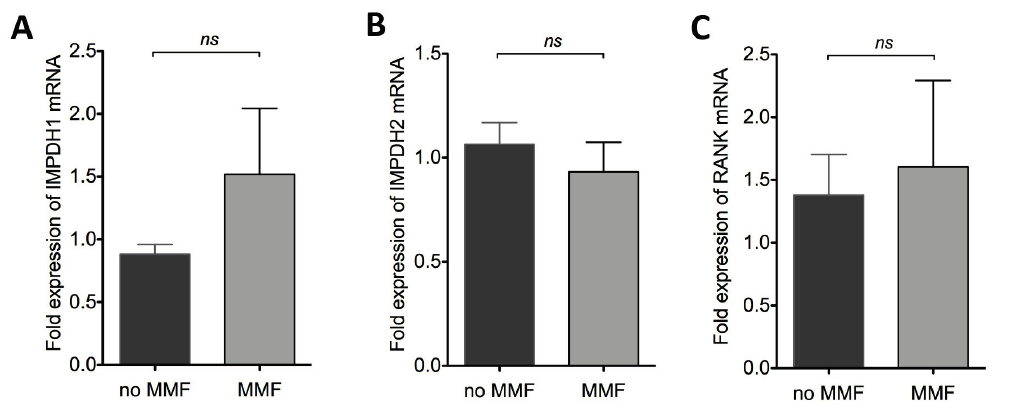
Figure 3. MMF therapy does not affect mRNA expression of IMPDH1, IMPDH2, and RANK in differentiated osteoclasts. mRNA was extracted from differentiated osteoclasts from SLE patients with ( n = 5) and without MMF ( n = 15) therapy. cDNA synthesis was carried out, and qPCR analysis of ( A ) IMPDH1, ( B ) IMPDH2 and ( C ) RANK was performed using SYBR Green and quantified by ΔΔ C t method, normalized to two different housekeeping genes RPL27 and GAPDH. ns: not